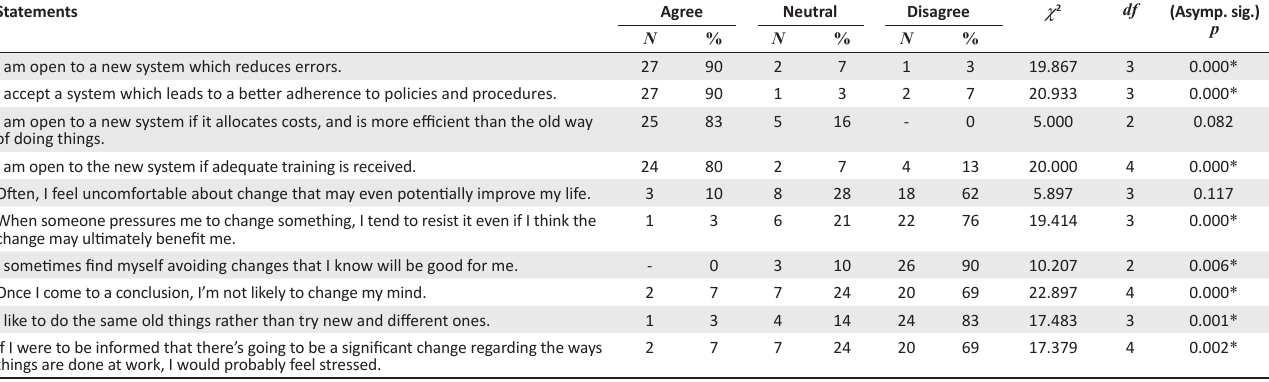
TABLE 5: Resistance to